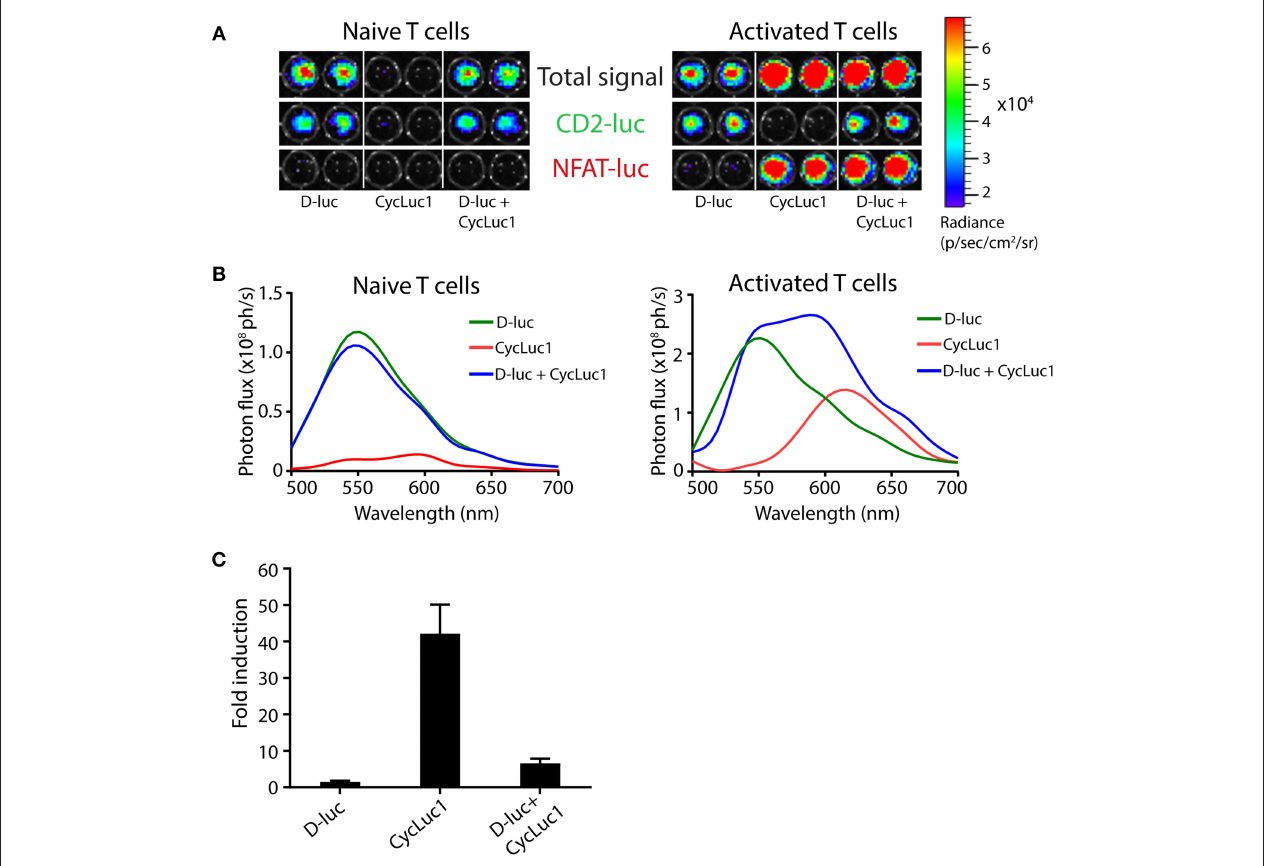
FIGURE 4 | Efficient visualization of NFAT-induced PpyRE9 luciferase using the CycLuc1 substrate. (A) CD8T cells from TbiLuc*OT-I mice left untreated (“Naive T cells”) or stimulated overnight with OVA immune complex-loaded dendritic cells (“Activated T cells”) were imaged using the substrate D-luciferin (D-luc), CycLuc1, or both, as indicated. Total signal (top), the constitutive green CD2-luciferase (middle) and the activation-induced red NFAT-luciferase (bottom) are shown separately, all on the same scale. (B) Emission spectra of naive T cells and of activated T cells (from Figure A) using different substrates, showing strong constitutive CBG99 signals using the D-luciferin substrate, and specific activation-induced PpyRE9 signals using CycLuc1. (C) Fold induction of NFAT-luciferase expression in TbiLuc*OT-I cells after incubation with OVA-IC DCs compared to unstimulated cells and BLI measurement using D-luc, CycLuc1 or both. Signals are corrected for differences in constitutive CD2-luciferase expression. Mean + SD. Representative data from two independent